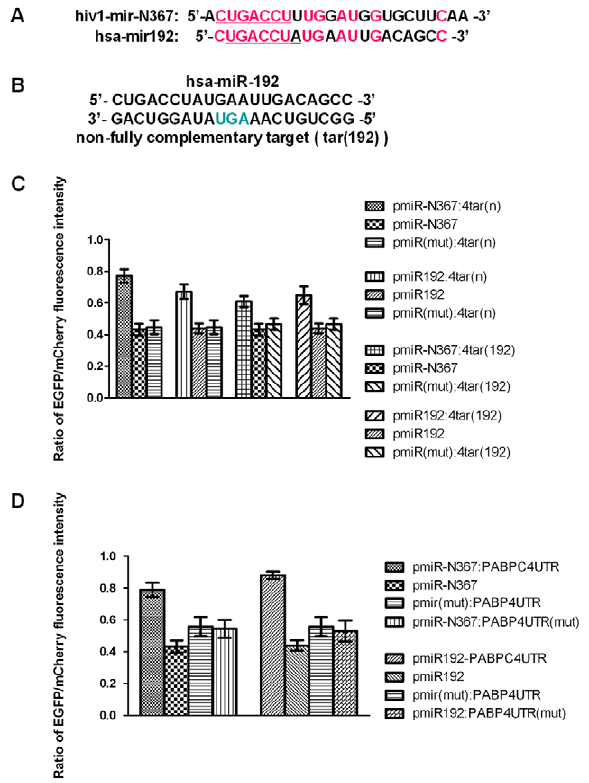
Figure 6. hiv1-miR-N367 and hsa-miR192 act as functional orthologs. (A) Sequence homology between hiv1-miR-N367 and hsa- miR192 (marked in red). The seed regions of miRNAs were underlined. (B) Sequences of miR192 and its non-fully complementary target. (C) Fluorescence reporter assay of the indicator vectors pmiR-N367:4tar(n), pmiR192:4tar(n), pmiR-N367:4tar(192), pmiR192:4tar(192) and their control vectors with miRNAs or target sequences only. (D) Fluorescence reporter assay of the indicator vectors pmiR-N367:PABPC4UTR, pmiR192:PABPC4UTR and their control vectors with miRNAs only, with miRNA deletions or without miRNA pairing sites in the 3 9 -UTR.